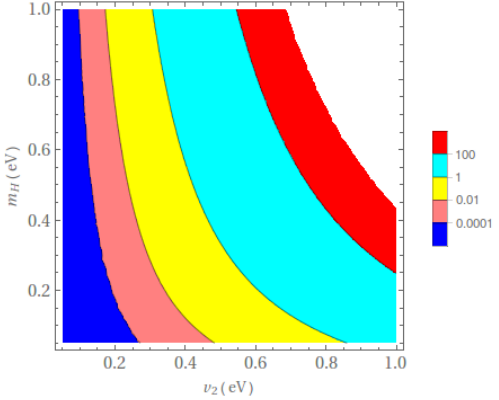
as shown in eq. (3.4) for active m (cid:23) = 0 : 03 eV, m (cid:23) = 0 : 1 eV (left) b. in 3 1 = 0 : 1 eV (right). 1